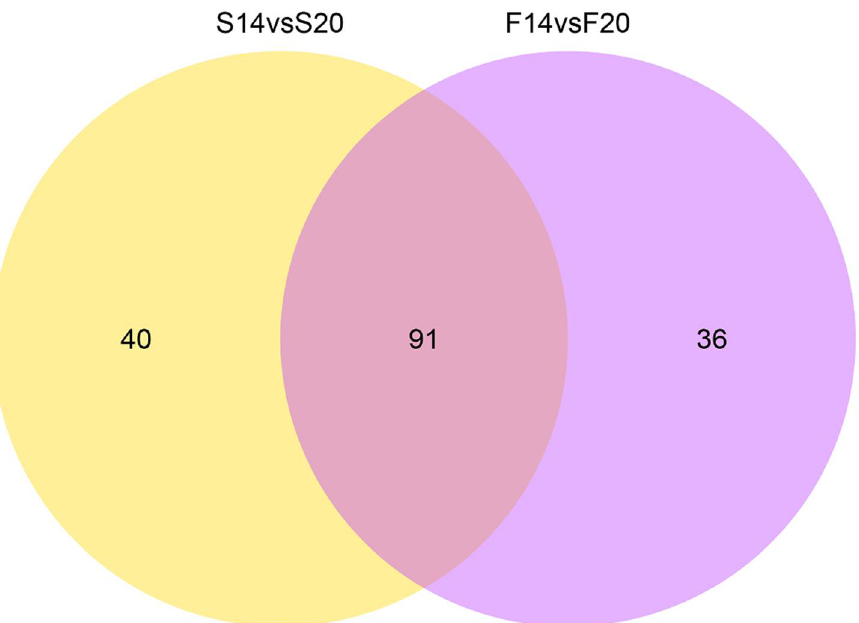
Figure 3. Venn diagram of DEMs in two comparison groups. The circles represent different comparison groups, and numbers represent the number of DEMs.